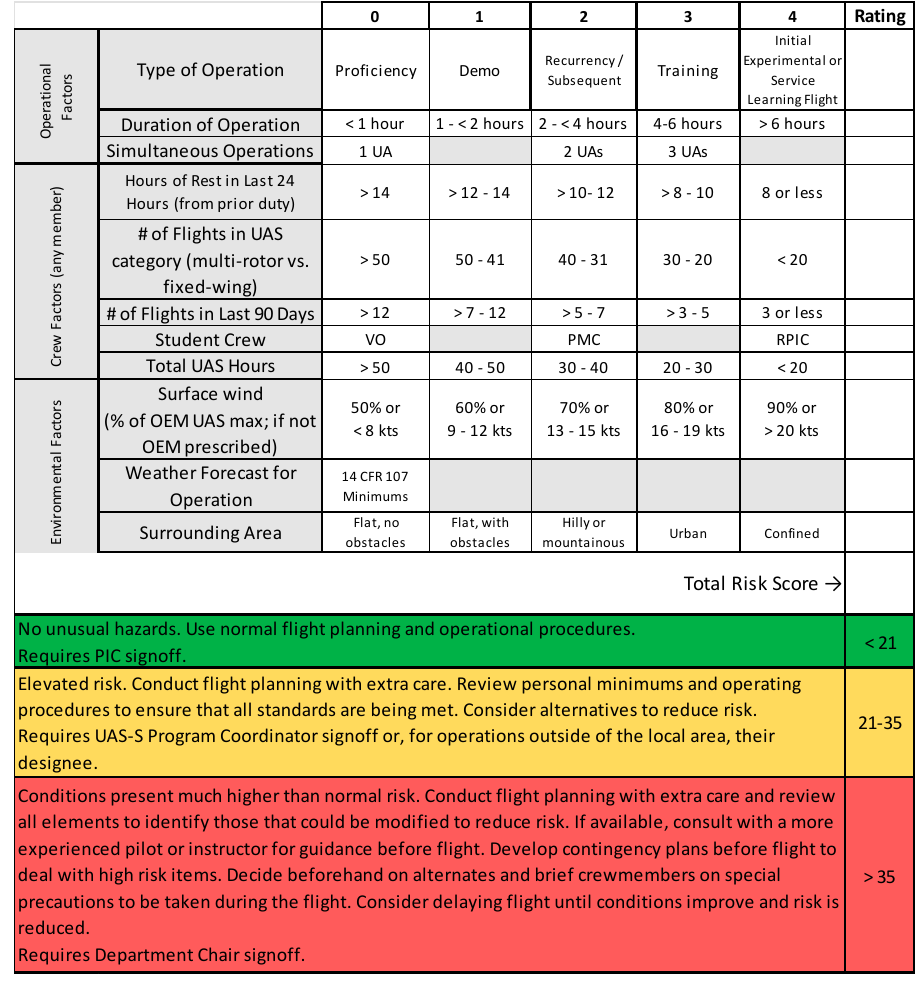
Figure 4. Flight Risk Assessment Tool (FRAT).